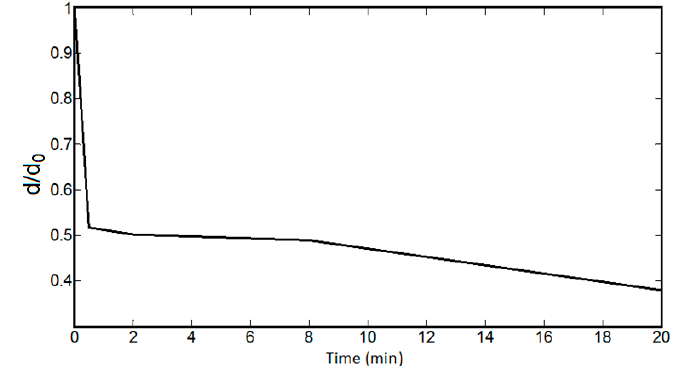
Figure 12. Sharp decay of the diameter of spider silk nanofiber yarns versus time. In the first minute of humidity exposure, the diameter is dramatically decreased.